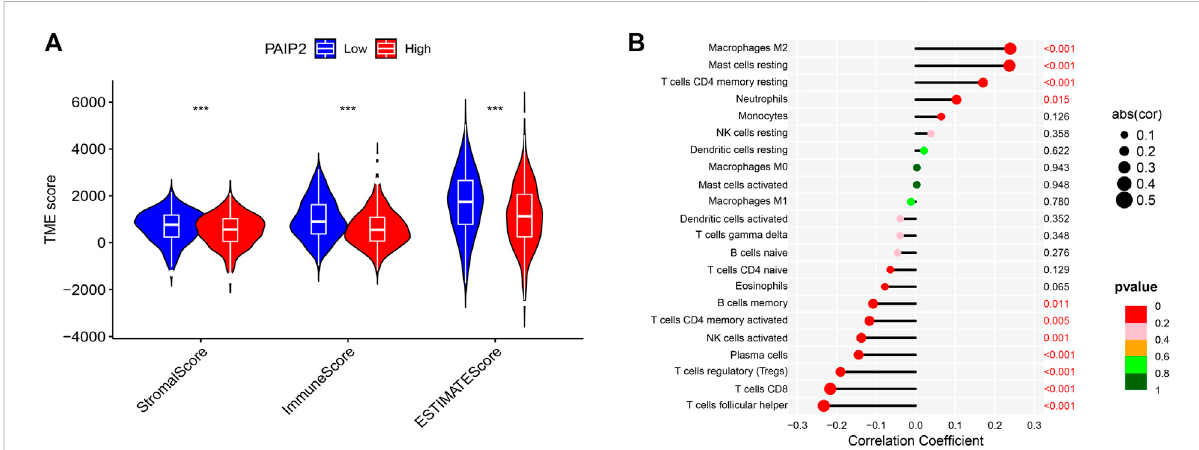
FIGURE 6 Tumor microenvironment score and immune cell in fi ltration. (A) : StromalScore, ImmuneScore and ESTIMATEScore of PAIP2 low expression group were signi fi cantly higher than those of PAIP2 high expression group (*represented p < 0.05, ** represented p < 0.01 and *** represented p < 0.001). (B) : The expression of PAIP2 was signi fi cantly positively correlated with the in fi ltration of Macrophages M2, Mast cells resting, T cells CD4 memory resting and Neutrophils. It was signi fi cantly negatively correlated with T cells follicular helper, T cells CD8, T cells regulatory, plasma cells, NK cells activated, T cells CD4 memory activated and B cells memory.